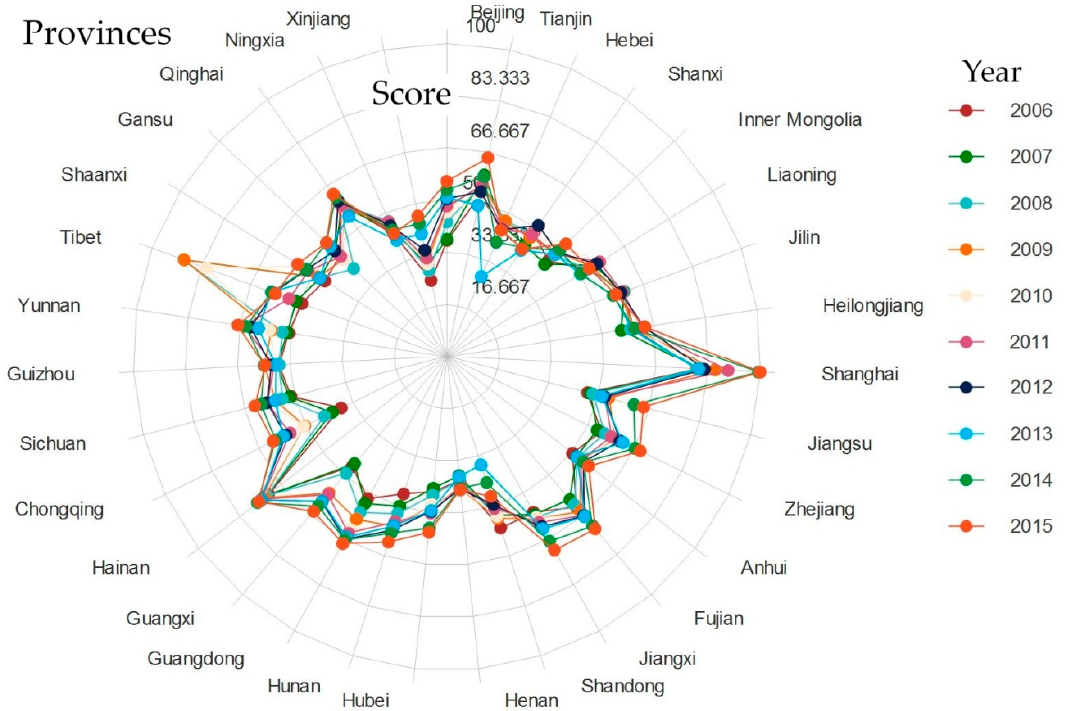
Figure 3. The radar chart of environmental eco-efficiency in the Chinese provinces from 2006 to 2015.